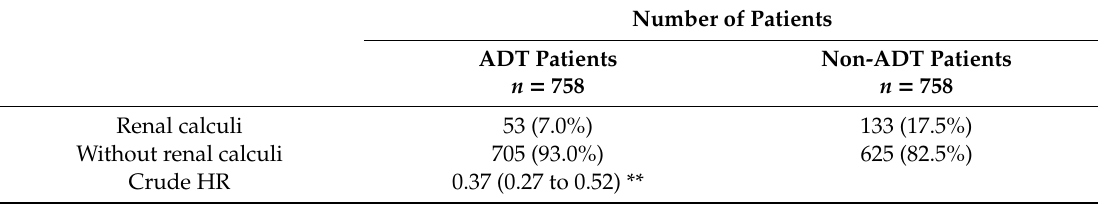
Table 2. ADT patients and non-ADT patients as predictors of renal calculi by Cox regression analysis.